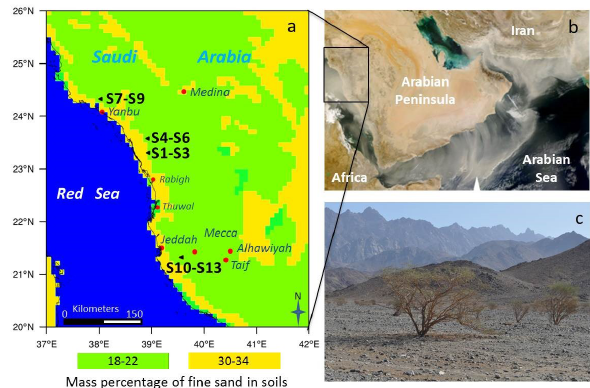
Figure 1. (a) Map showing the mass percentage of fine sand in soils, based on STATSGO-FAO soil-texture data (Nickovic et al., 2012; Menut et al., 2013), in the Arabian Peninsula, as well as the four lo- calities and 13 (S1–S13) sampling sites. (b) MODIS satellite image of dust storm over the Arabian Peninsula captured on 22 Febru- ary 2008 (NASA MODIS web site). (c) Sampling site S1 showing the typical acacia trees growing along the wadi in the foreground, with the Hijaz mountain range and escarpment in the